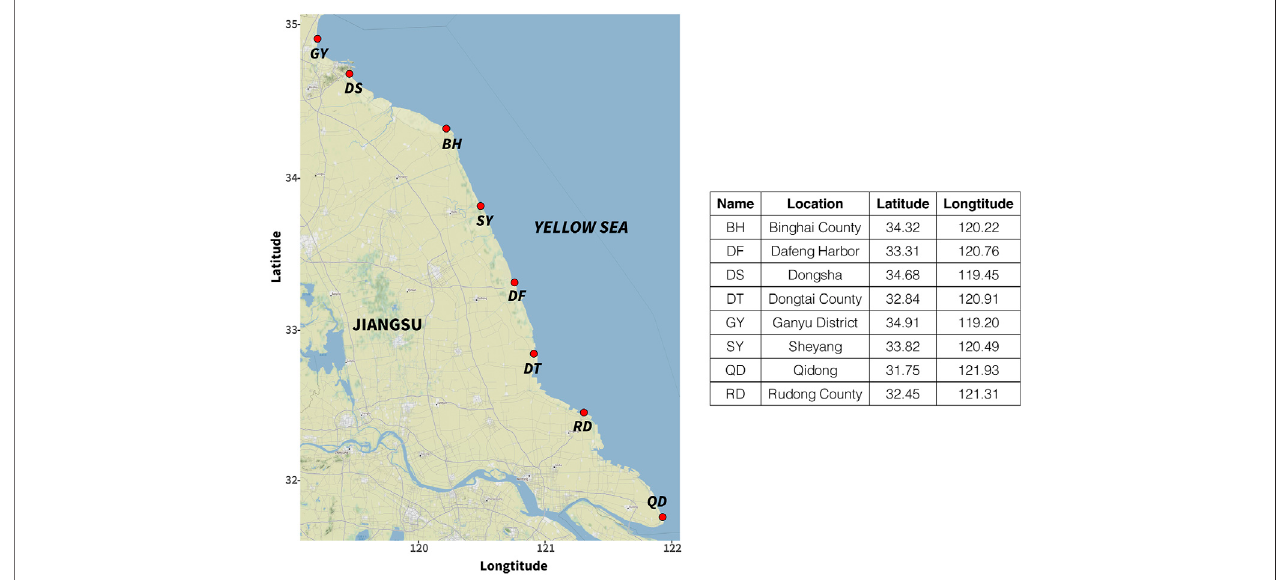
FIGURE 1 | Sampling sites (red dot) of Clams cultivated in Jiangsu Province (the map was generated with R studio by using the “ ggmap ” package, map was sourced from “ google map ” ).